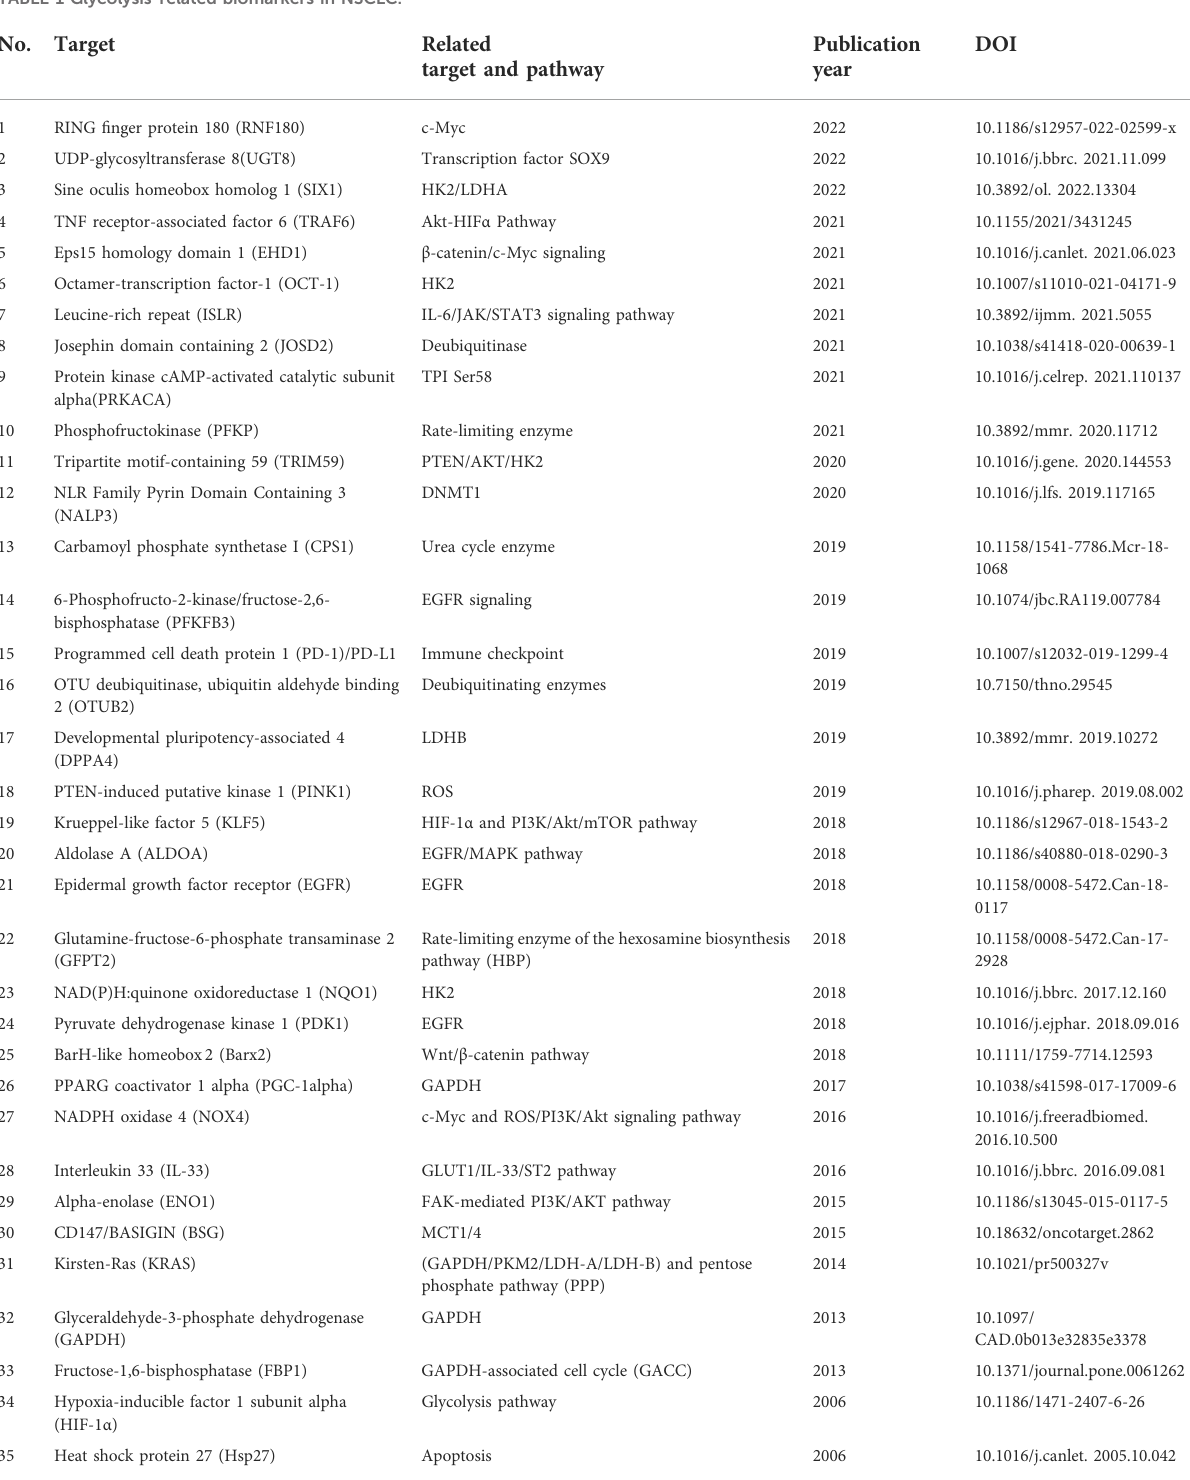
TABLE 1 Glycolysis-related biomarkers in